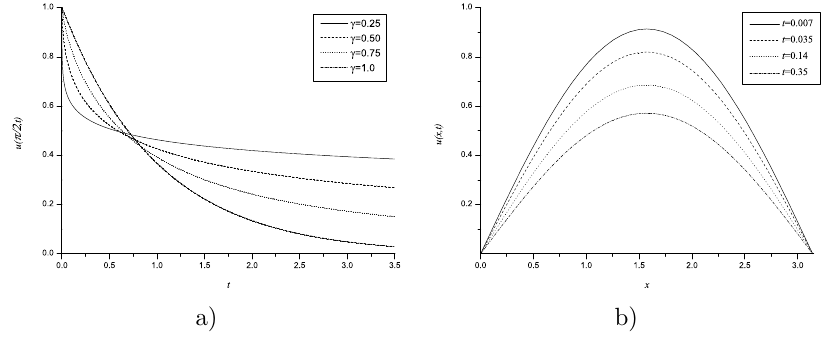
Figure 1. Numerical solutions of the diffusion problem: a) numerical solutions of u ( π/ 2 ,t ) for ∆t = 0 . 00007 and M = 40 at different time levels, b) for γ = 0 . 50 and M = 40 at different time